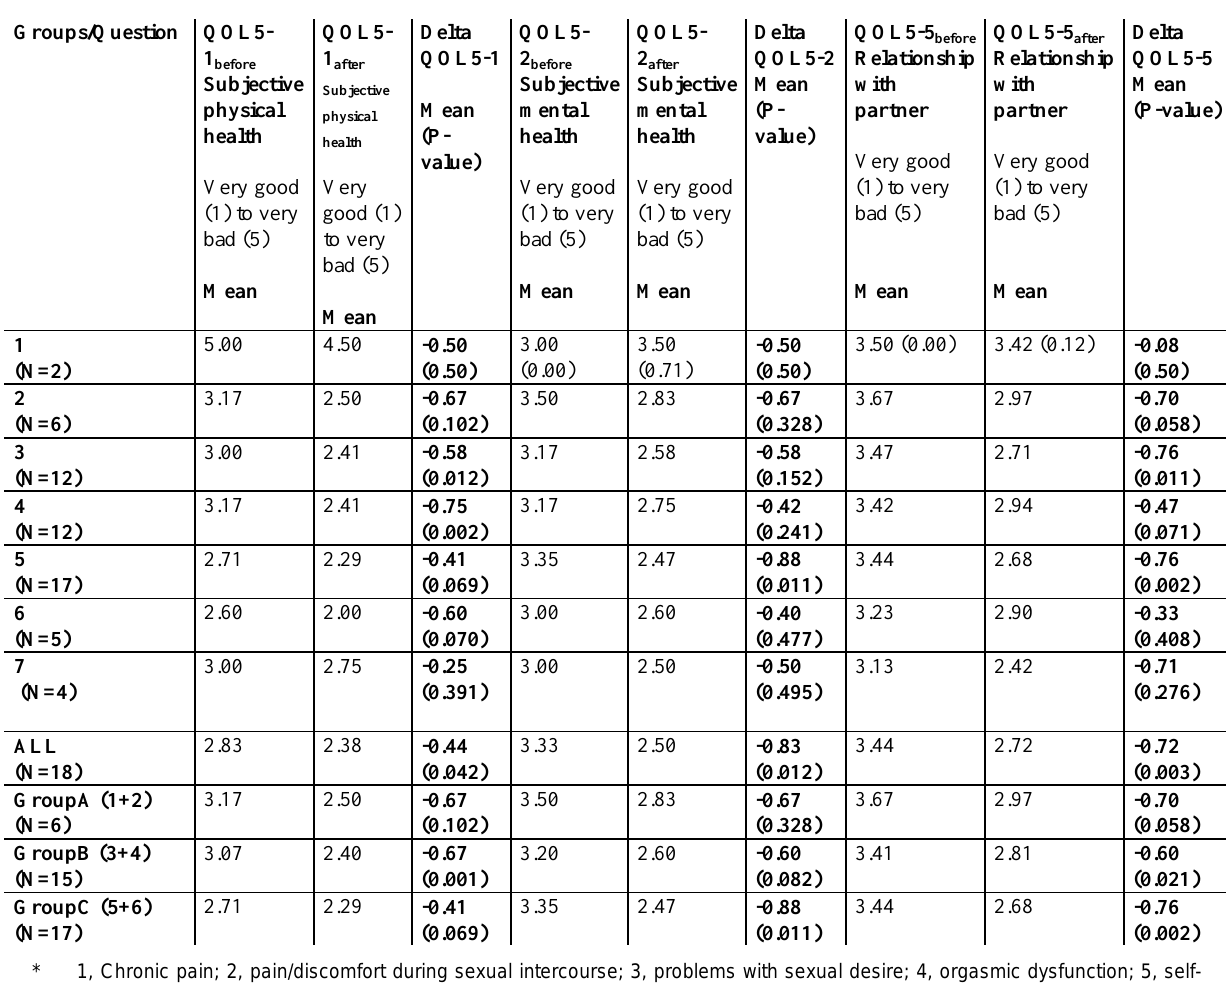
Clinical Effect of Vaginal Acupressure. Subjective physical and mental health, quality of relationship with partner before and after VA